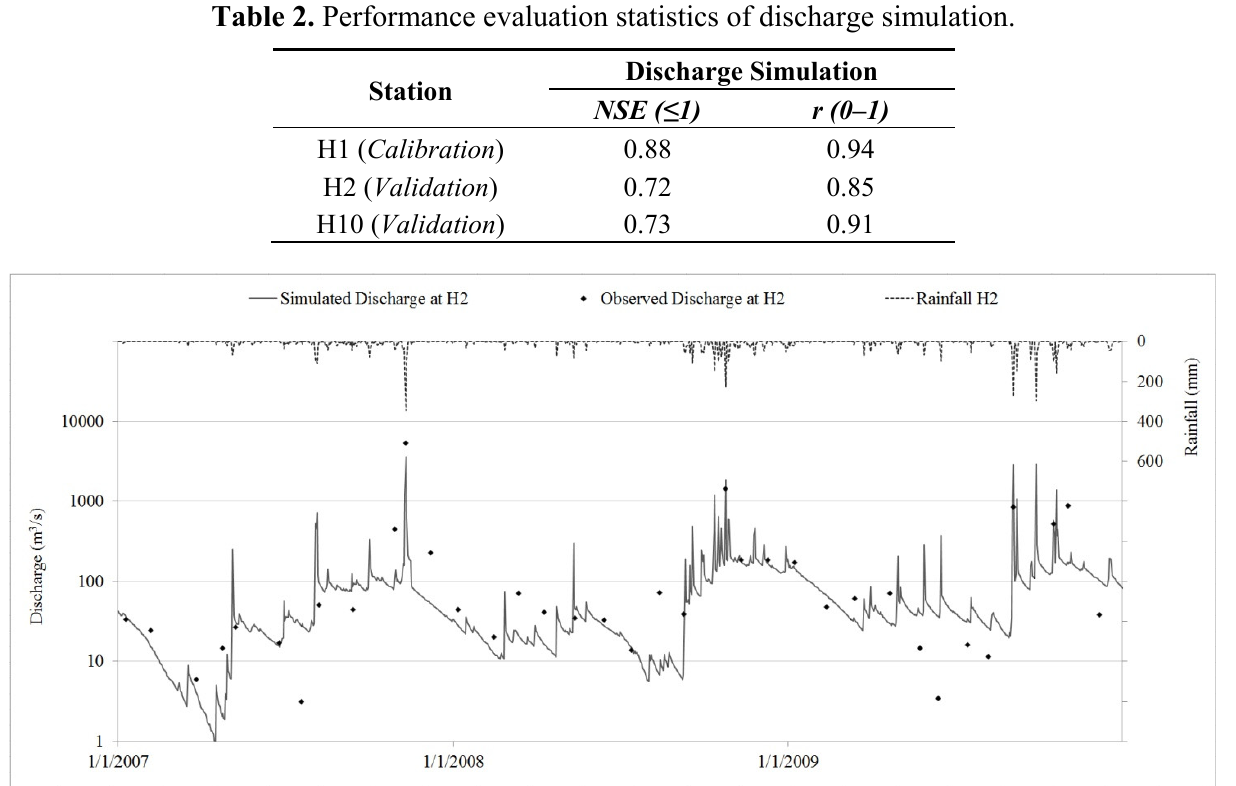
Figure 3. Discharge validation at